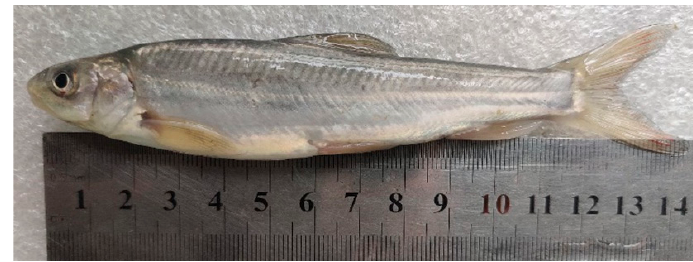
Figure 1. Experimental fish: Schizopygopsis malacanthus .